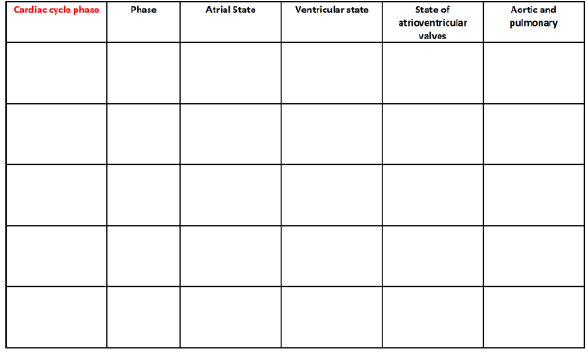
Figure 2. Table for placing chips in stage 2 of printed cardiac cycle puz- zle (adapted from Marcondes et al.